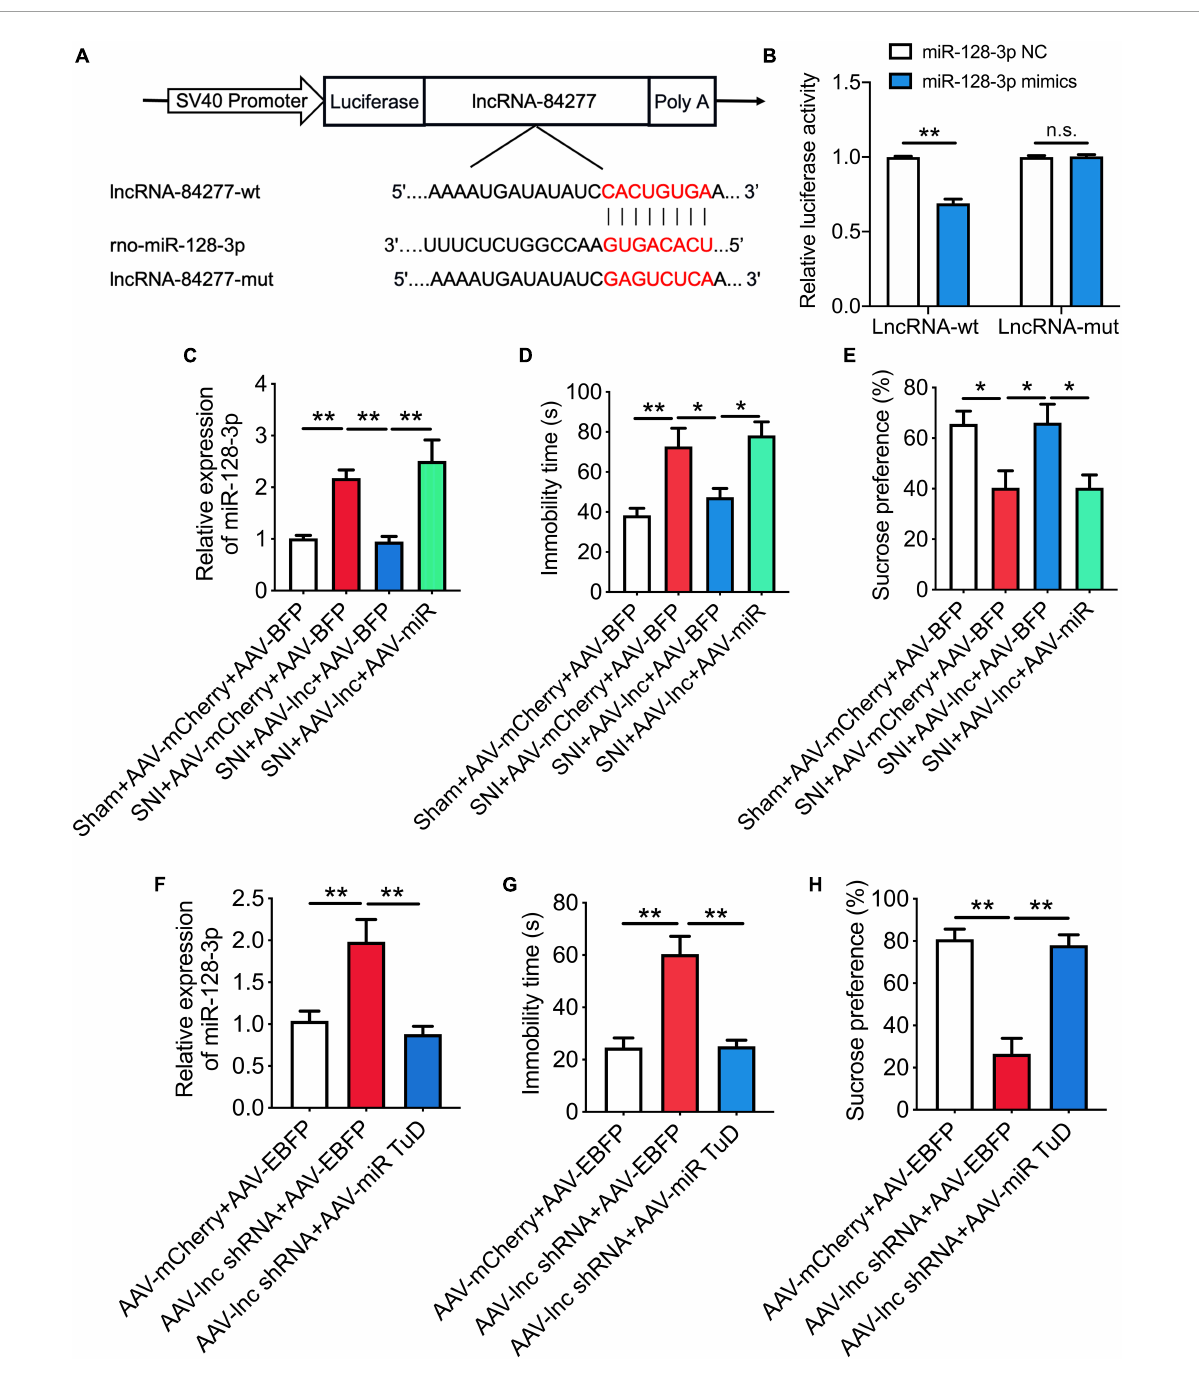
FIGURE5 LncRNA-84277 improves depression-like behaviors through inhibiting miR-128-3p. (A) The predicted potential binding sites of miR-128-3p to lncRNA-84277 and schematic of wild-type (wt) and mutant-type (mut) of lncRNA-84277. (B) Relative luciferase activity of wild type or mutated lncRNA-84277 after co-transfection with miR-128-3p mimics ( n = 3). (C) Effect of lncRNA-84277 overexpression on the level of miR-128-3p and its influence by miR-128-3p overexpression in SNI rats ( n = 8). (D,E) Effect of miR-128-3p overexpression on lncRNA-84277 overexpression-mediated improvement of depression-like behaviors in SNI rats determined by the forced swim test (D) and the sucrose preference test (E) ( n = 8). (F) Effect of lncRNA-84277 knockdown on the level of miR-128-3p and its influence by miR-128-3p knockdown in naïve rats ( n = 8). (G,H) Effect of miR-128-3p knockdown on lncRNA-84277 knockdown-mediated depression-like behaviors in naïve rats determined by the forced swim test (G) and the sucrose preference test (H) ( n = 8). All data are expressed as the mean ± SEM. * P < 0.05, ** P < 0.01. n.s., not